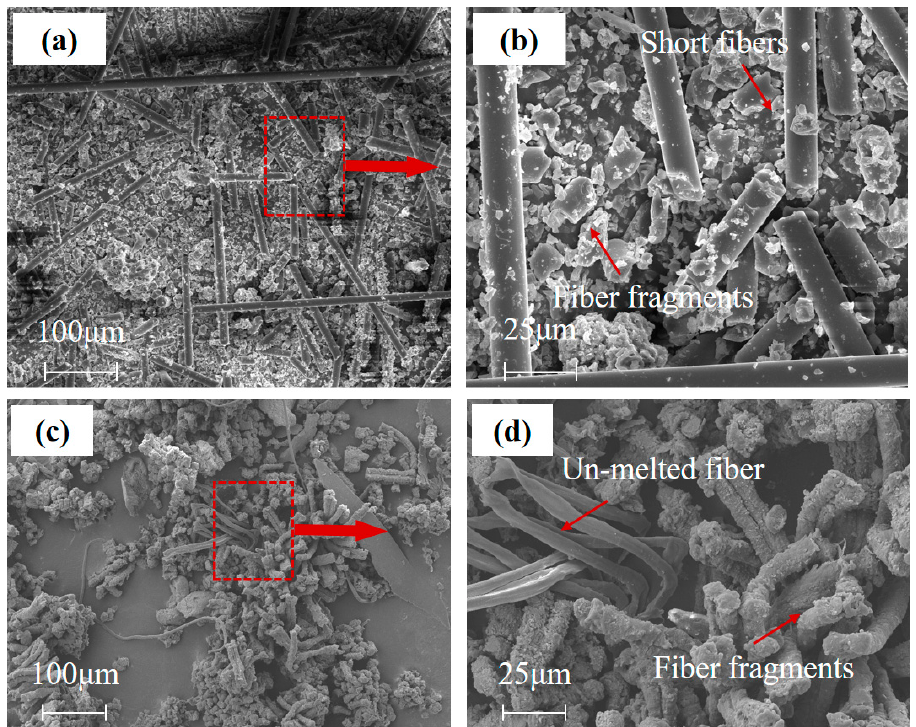
Figure 11. Micromorphology of fiber fragments. ( a ) Fragments of Basalt fiber. ( b ) Broken short fiber and fragments of Basalt fiber. ( c ) Fragments of UHMWPE fiber. ( d ) Un-melted and fragments of UHMWPE fiber.